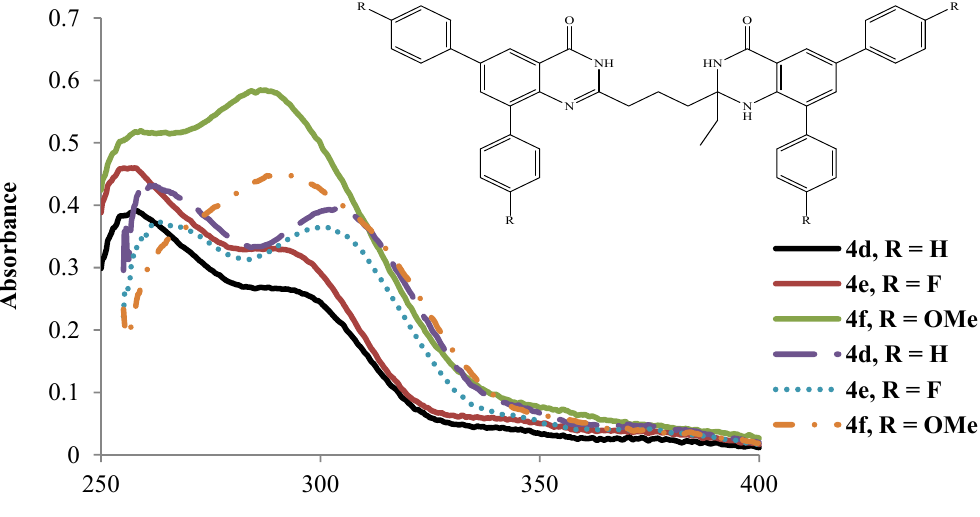
Figure 3. UV-Vis spectra of 4d – f in DMSO (dashed lines) and CH (conc. = 1.0 × 10 − 5